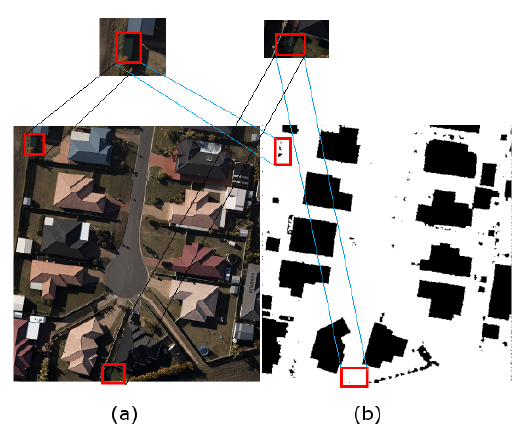
Figure 1: (a) Orthoimage; (b) Primary mask. Missing buildings of the reference method are marked by red coloured region in both images.